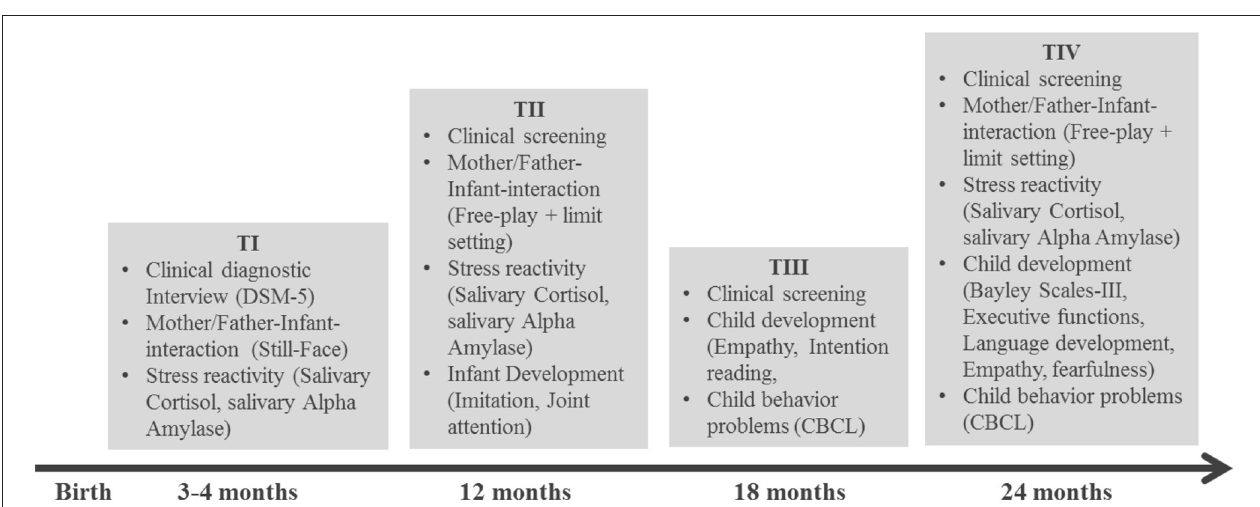
FIGURE 2 | Sample of COMPARE-emotion. fMRI, functional magnetic resonance imaging.